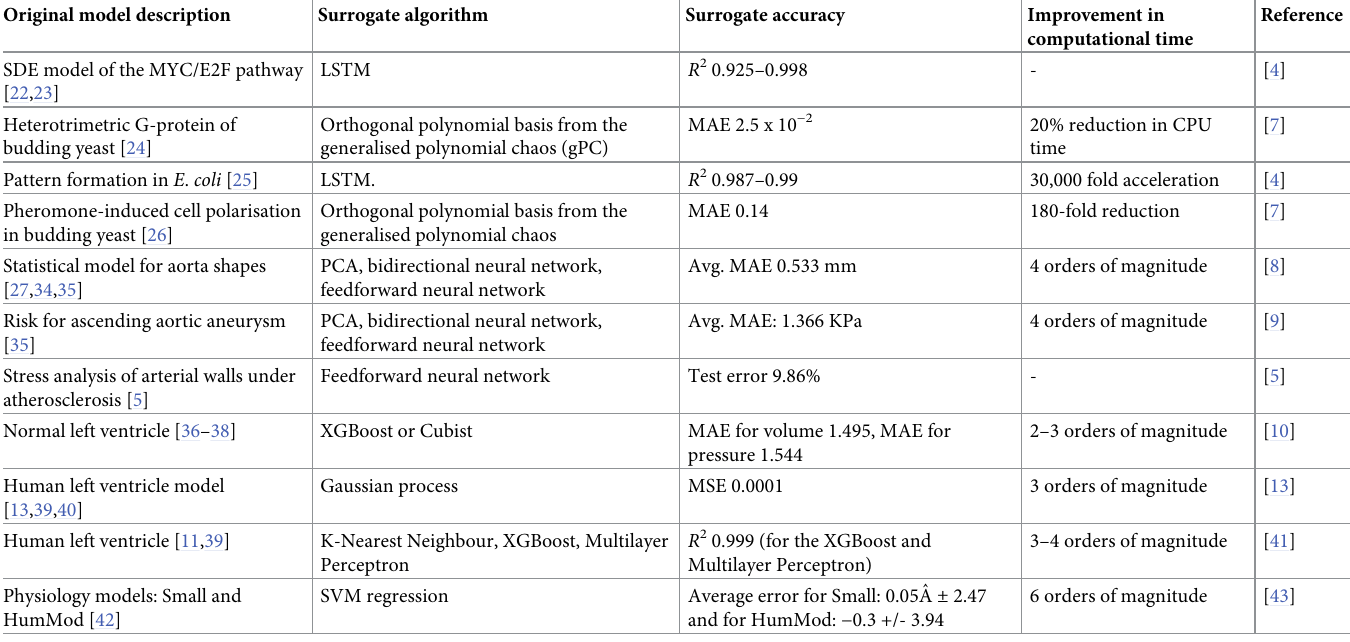
Table 1. Summary of the performance and methodologies of the ML surrogates of the systems biology models.